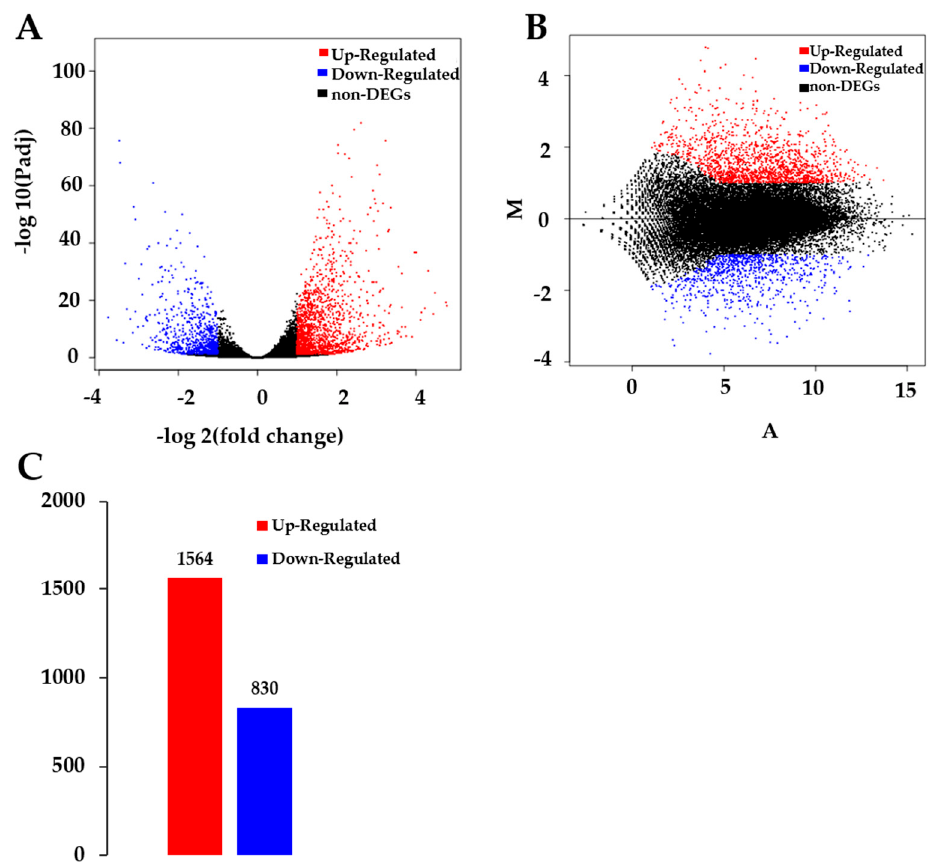
Figure 2. Analysis of differentially expressed genes (DEGs) between control and treatment groups. ( A ) Volcano plot of DEGs. The x-axis represents the log2-transformed fold change. The y-axis represents the -log10-transformed significance. ( B ) Minus-versus-add (MA) plot of DEGs. The x-axis represents value A (log2-transformed mean expression level). The y-axis represents value M (log2-transformed fold change). Red points represent up regulated DEGs. Blue points represent down regulated DEGs. Black points represent non-DEGs. ( C ) Summary of DEGs. The x-axis represents the compared samples. The y-axis represents DEG numbers. Red color represents up-regulated DEGs. Blue color represents down-regulated DEGs.